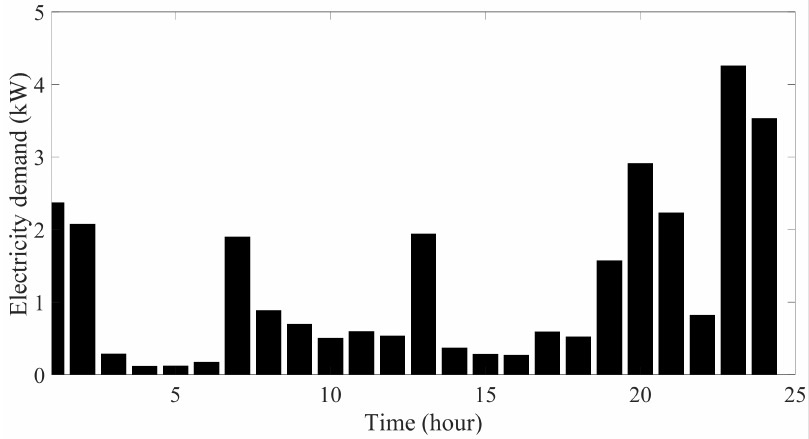
Figure 2. Daily demand curve—daily hourly values considering the load of an